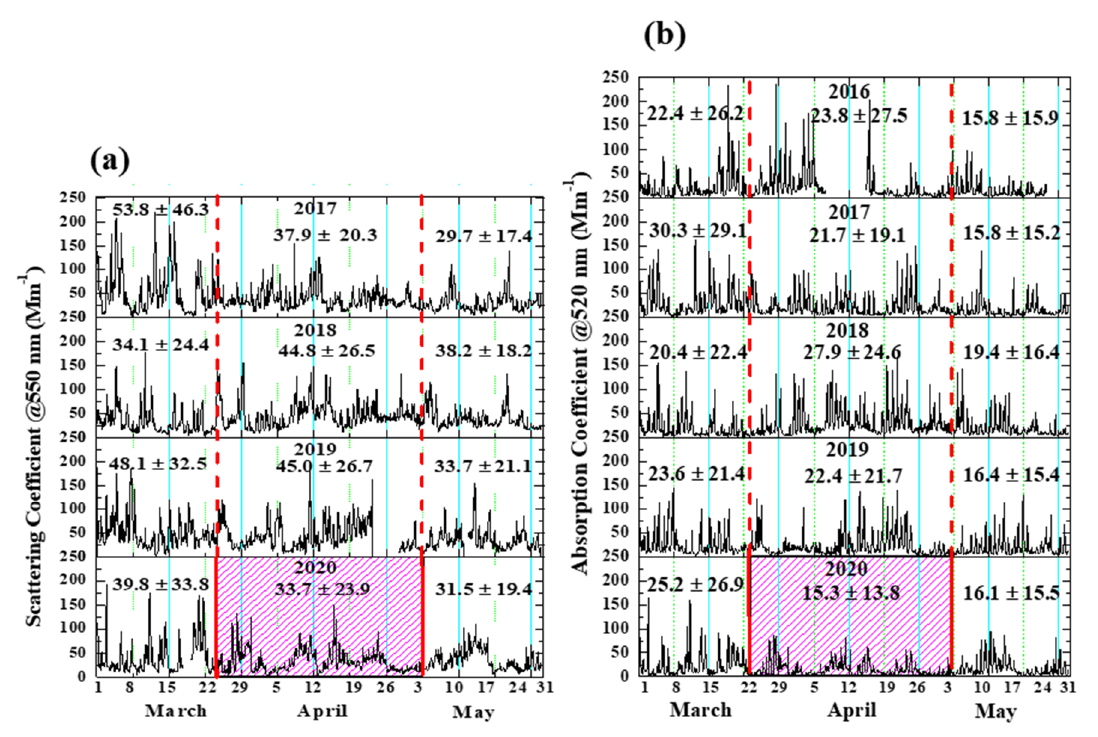
Figure 3. Time-series of hourly b sca,550 ( a ) and b abs,520 ( b ) during March–May for the years 2017–2020 and 2016–2020, respectively. The shaded area in 2020 corresponds to the lockdown period, and the red lines indicate periods before and after the lockdown. Mean values and standard deviations for each sub-period are mentioned in each panel.